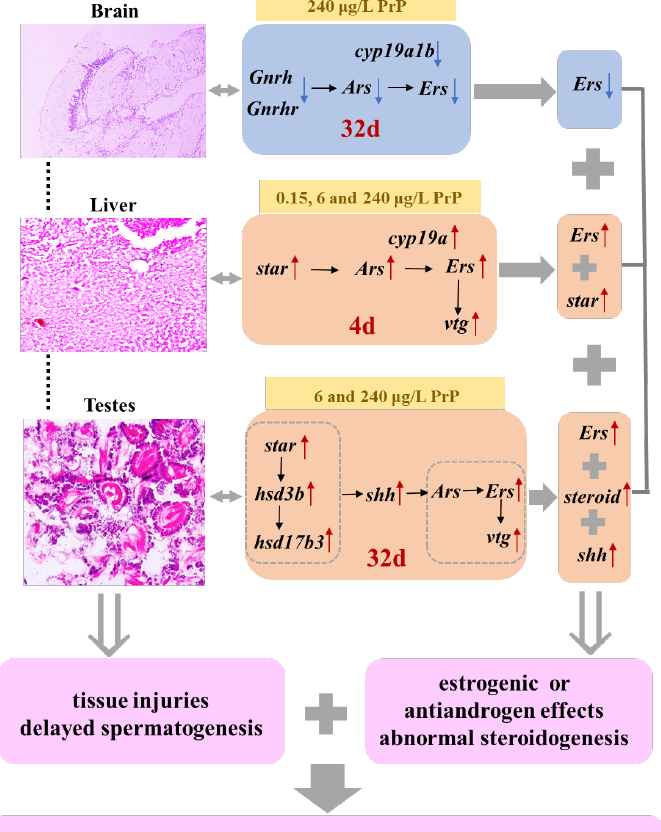
Figure 6. Overview of toxic effects and endocrine disruption in the male mosquitofish suffered from 0, 0.15, 6, 240 μg/L PrP for 4d and 32d. PrP exposure induced morphological injuries in the brain, liver and testes, and caused delayed spermatogenesis. The transcriptional level changes of the genes along the hypothalamus-pituitary-gonadal-liver (HPGL) axis suggested that PrP stimulated abnormal steroidogenesis, estrogenic effects or antiandrogen effects.